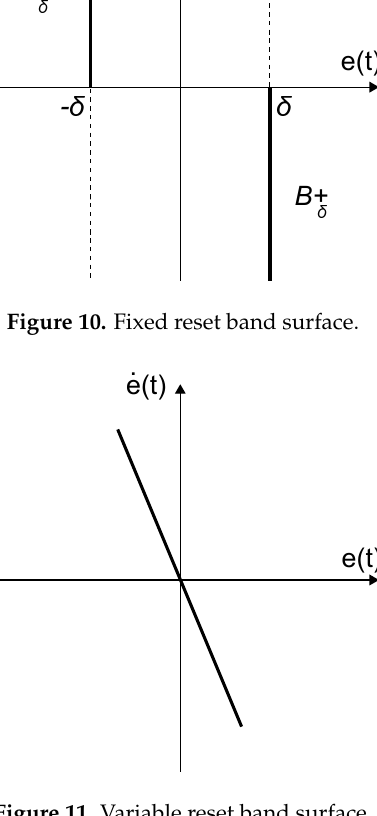
Figure 11. Variable reset band